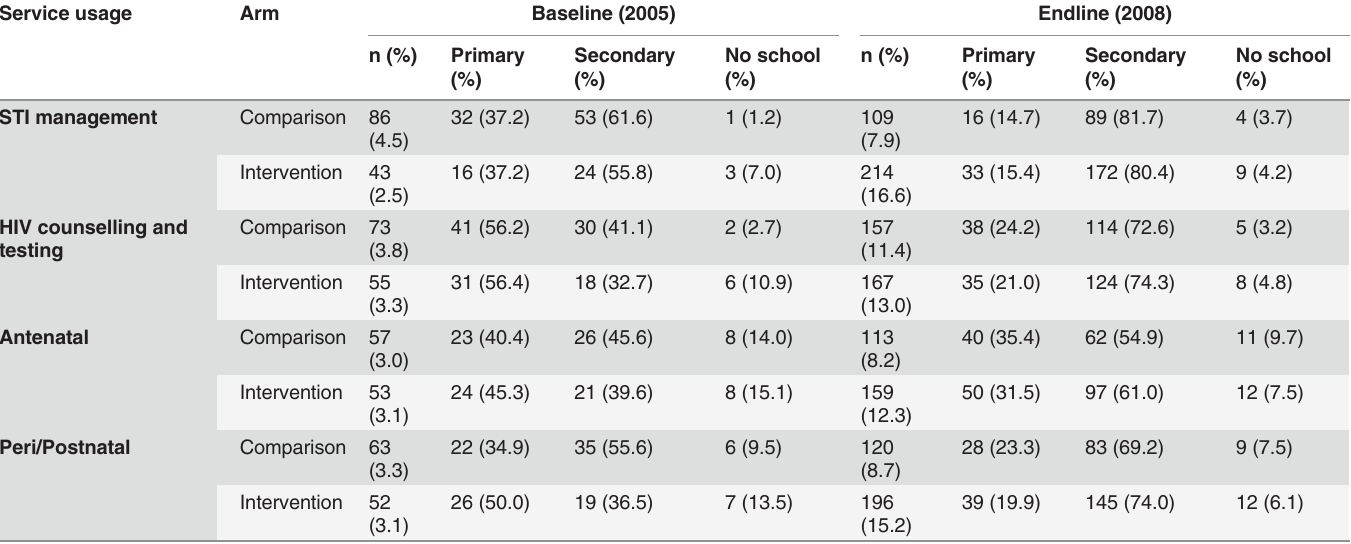
Table 3. SRH service usage among school-attending and out-of-school adolescents at baseline and endline. Service